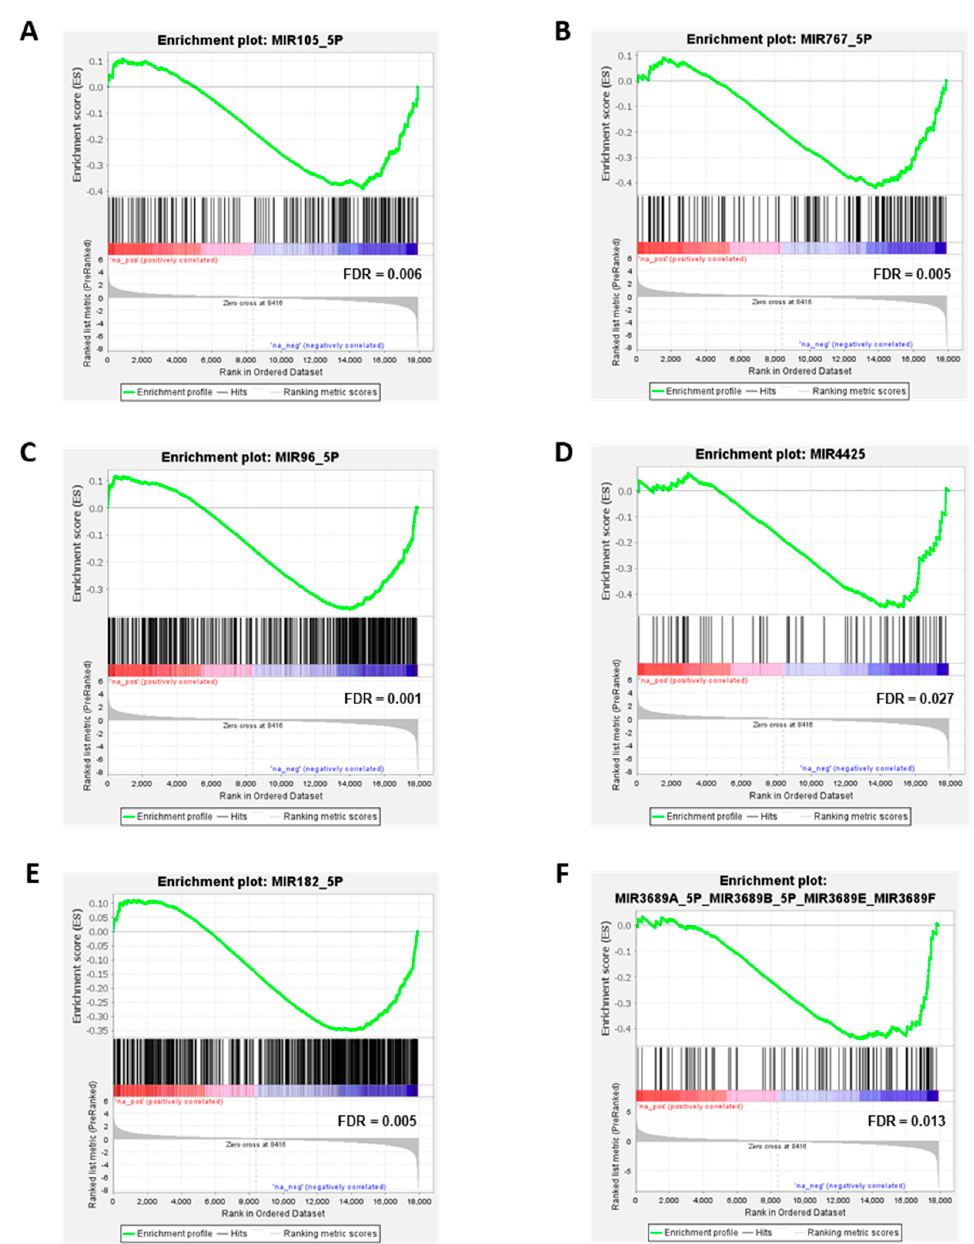
Figure 4. Significant downregulation of miRNA target genes in melanoma cells. Enrichment plot for ( A ) miR-105-5p, ( B ) miR-767-5p, ( C ) miR-96-5p, ( D ) miR-4425, ( E ) miR-182-5p, and ( F ) miR-3689F. Profile of the running enrichment score (green) and positions of gene set members of the respective miRNA target genes on the rank-ordered list of genes differentially regulated in melanoma cells compared to MBrCs and NHEMs identified by gene expression array analysis. Genes upregulated in melanoma are shown on the left side of the graph in red, genes downregulated in melanoma on the right side in blue.